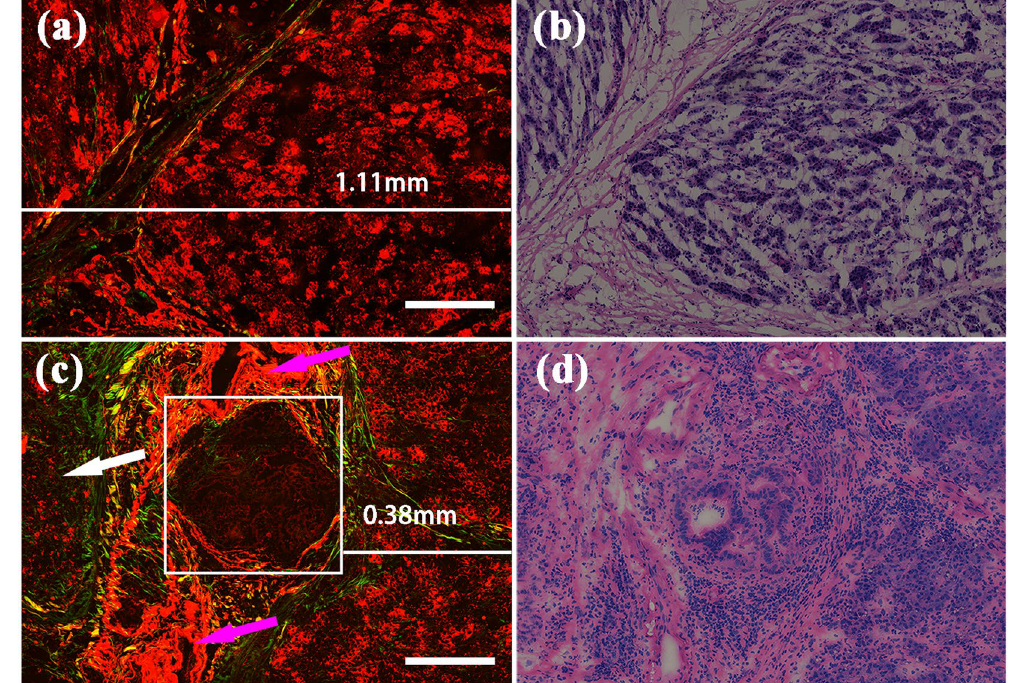
Figure 7. MPM images and corresponding H&E-stained images of R0 and R1 resections of the pancreatic neck margin. Magnification of H&E-stained images is 40 × ; Scale: 200 μ m. ( a ) MPM image of R0 resection; ( b ) The corresponding H&E-stained image of R0 resection; ( c ) MPM image of R1 resection; ( d ) The corresponding H&E-stained image of R1 resection. White arrows: increased collagen fibres; pink arrows: blood vessels; white box: neoplastic glands.